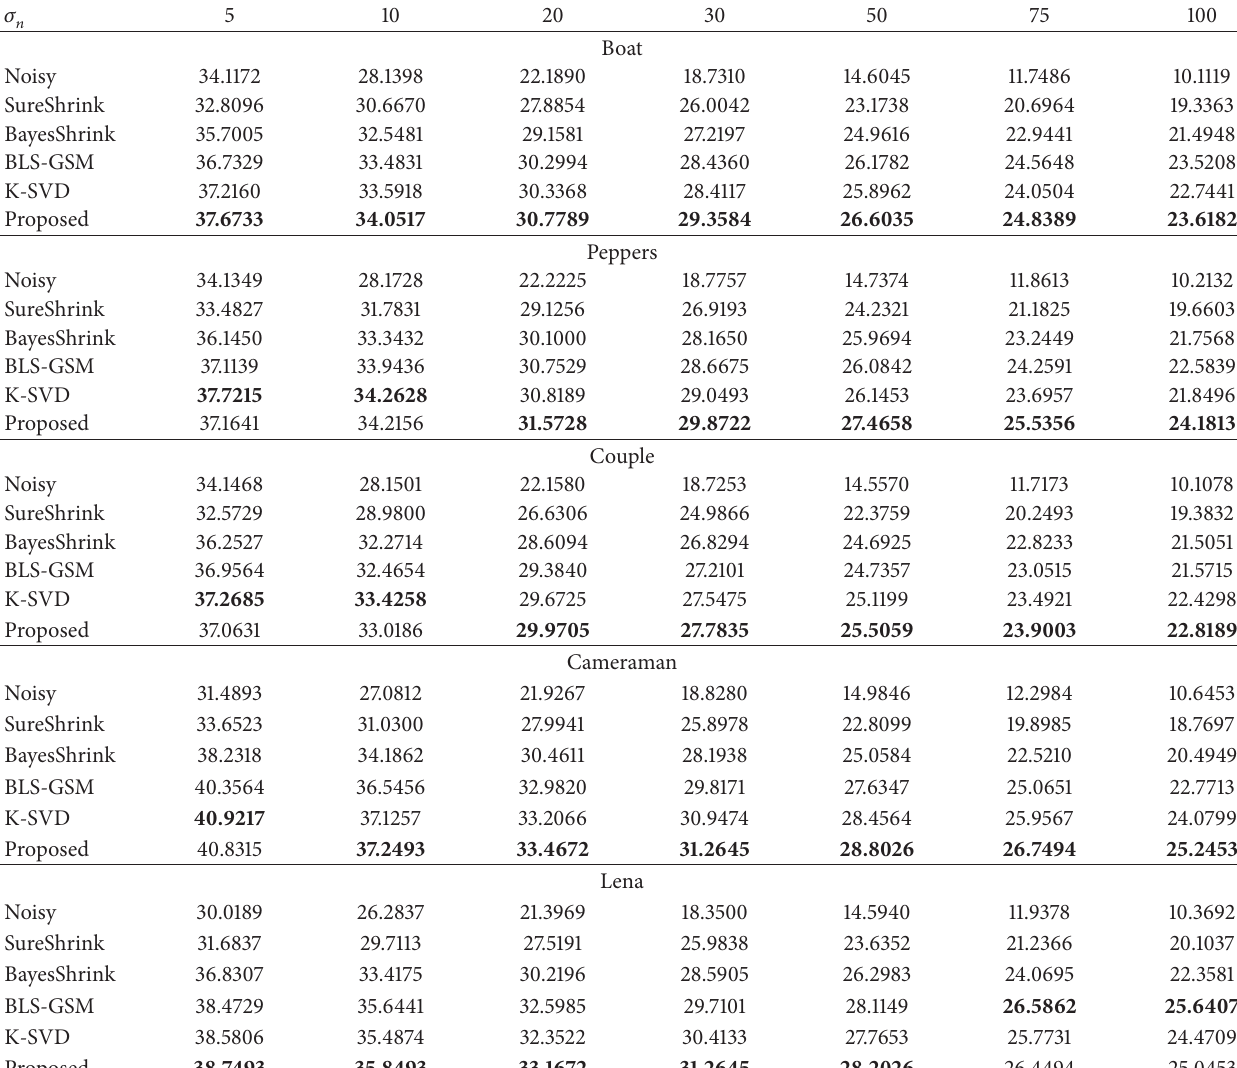
Table 2: PSNR comparison (Gaussian noise) of the proposed method with other methods (in dB).